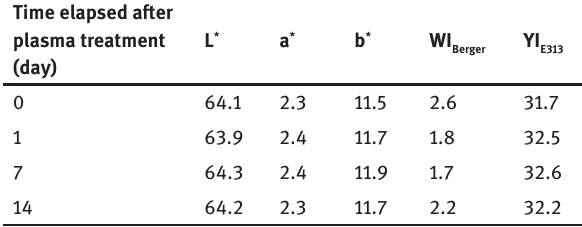
Time elapsed after plasma